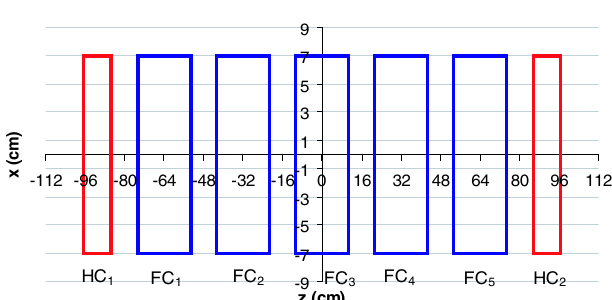
FIG. 5. (Color) Third order term of the transversal expansion of the magnetic field calculated with respect to the beam trajectory as a function of z in the configuration at